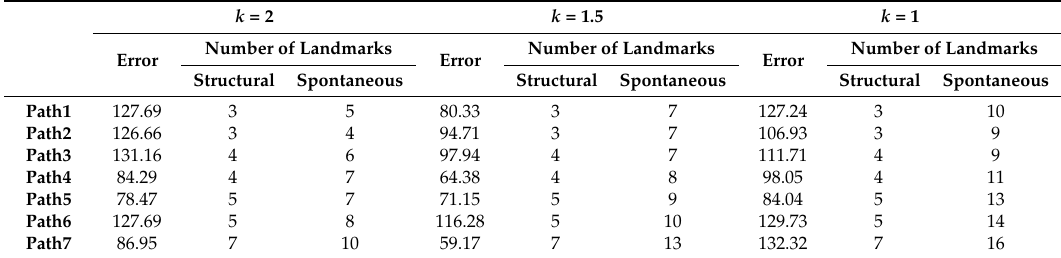
Table 3. Error distribution according to landmark density (unit: cm).